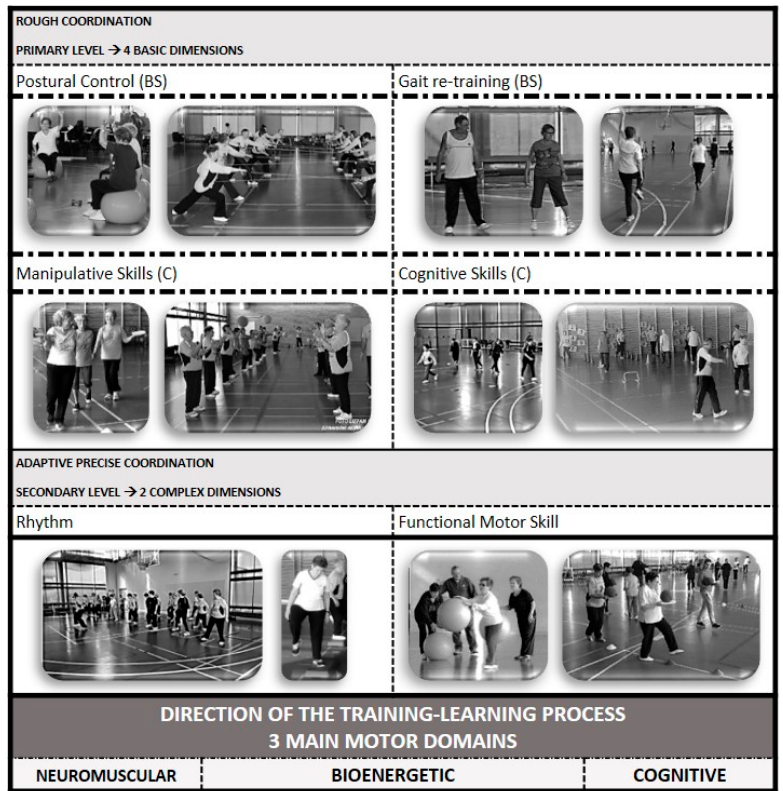
Figure 2. Six dimensions in the older adults’ functional-training psychomotor taxonomy in EFAM-UV © . The six dimensions are distributed in two levels (based on Schnabel, 1994, in Platonov [51]). Any task in the first level aims to improve at least one basic skill (BS: Postural control and / or Gait re-training), combined or not with other basic or complementary skills (C: Manipulative and / or Cognitive Skills). Once the technical improvements allow for individuals to move on with security, the methodology EFAM-UV© introduces new simple exercises but now from its advanced or secondary level. Two more complex dimensions in this level (R: Rhythm and FMS: Functional Motor Skills) help to achieve functional, adaptive, precise coordination. Different tasks in the two levels then (from neuromuscular, to cognitive and/or metabolic orientation), according to a periodized model (Figure 3) EFAM-UV© evolves through the physical–exercise continuum, from strength (neuromuscular contents) to bioenergetics, with cognition as a permanent target. The program is tailored and periodized, increasing and decreasing the psychophysiological load with regards to time of training, and participants’ capabilities and expertise.